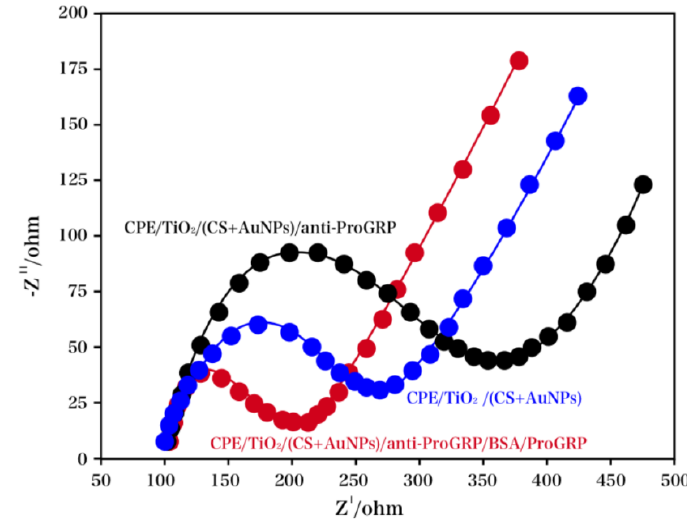
Figure 2. The electrochemical impedance spectroscopy (EIS) characterization recorded for different electrodes: CPE/TiO 2 /(CS+AuNPs), CPE/TiO 2 /(CS+AuNPs)/anti-ProGRP and CPE/TiO 2 /(CS+AuNPs)/anti-ProGRP/BSA/ProGRP.